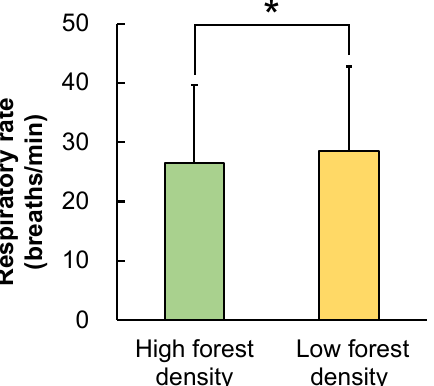
Figure 8. Effect on the respiratory rate “after exercise” between high forest density and low forest